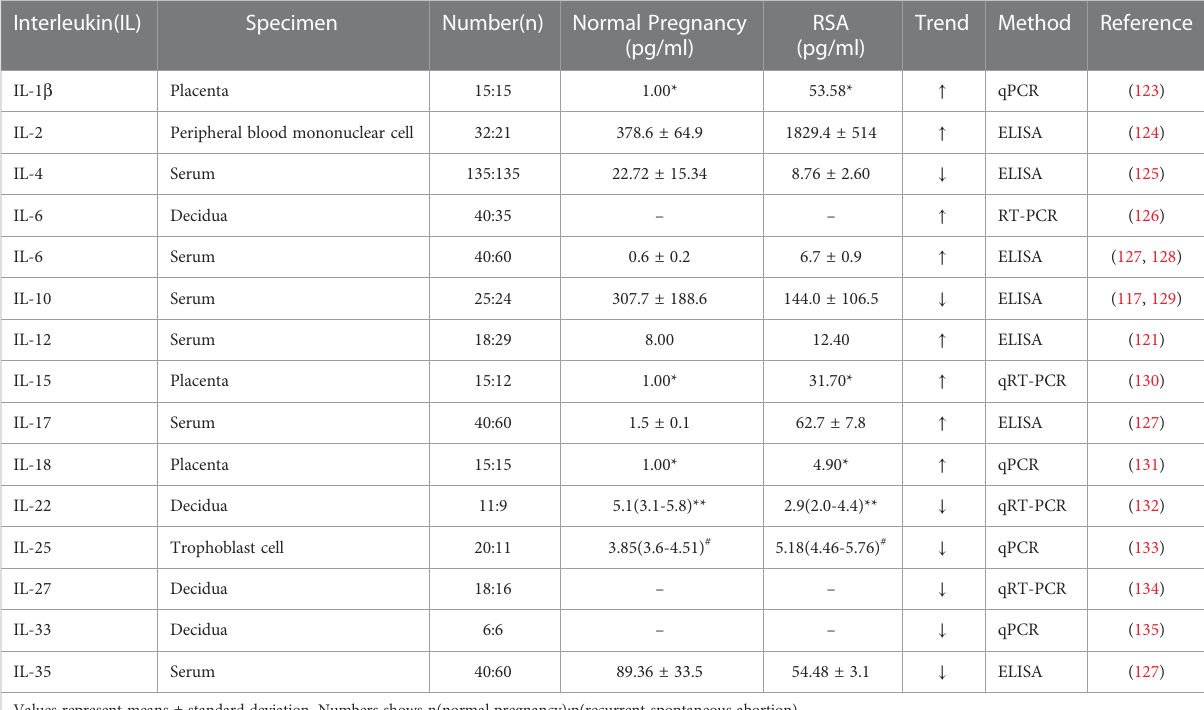
TABLE 1 Interleukin levels in normal human pregnancy and recurrent spontaneous abortion.